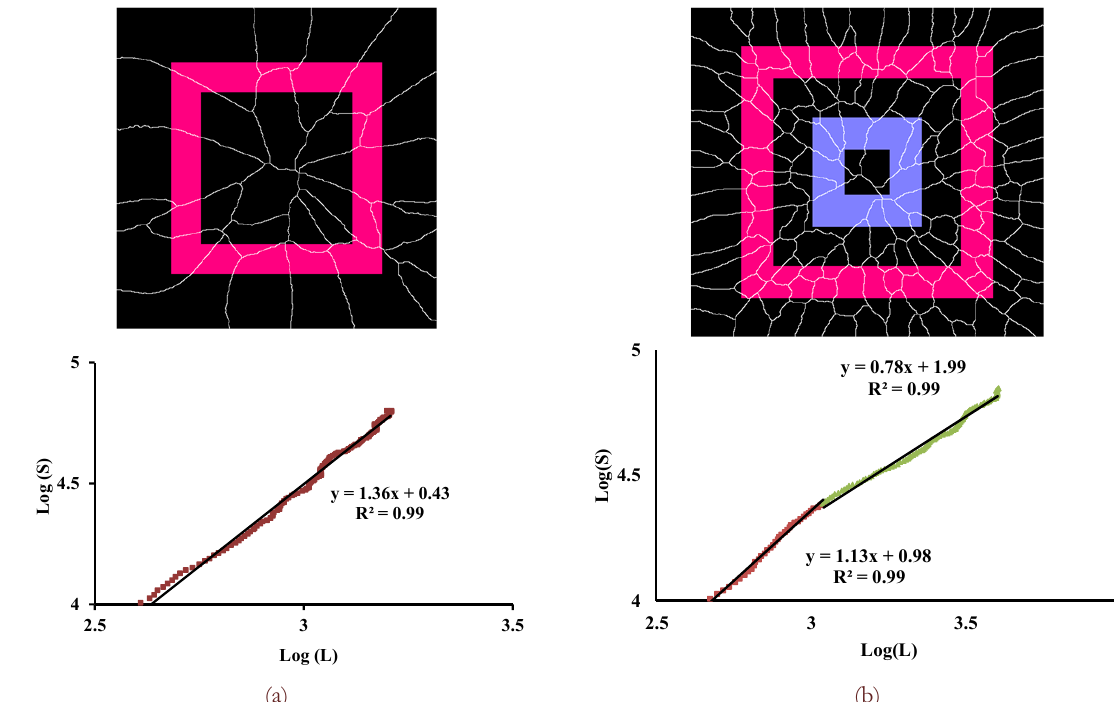
Figure 3: a) Fragmentation pattern and fractal dimension definition for the fracture accompanied by radial crack formation. b) Fragmentation pattern and fractal dimension definition for the fracture accompanied by a change in the fracture